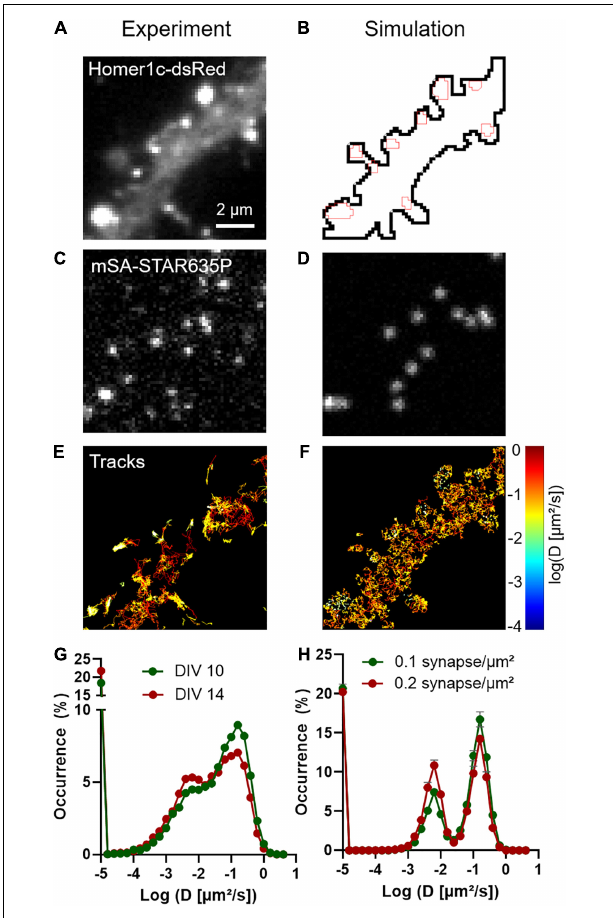
FIGURE 1 | Diffusional trapping of NLGN1 at synapses probed by uPAINT. (A) Raw image of a dendritic segment from a neuron co-expressing BFP + shRNA to NLGN1, AP-NLGN1, BirA ER , and Homer1c-DsRed. (B) The Homer1c-DsRed image was used as a reference to draw the dendrite outline (black) and the PSDs (red areas) entered in the simulator. (C) Biotinylated AP-NLGN1 was sparsely labeled with STAR635P-conjugated mSA, allowing the tracking of individual NLGN1 molecules by uPAINT. (D) Realistic fluorescence rendering of simulated individual NLGN1 molecules in the defined geometry. (E) Image of individual NLGN1 trajectories (2667 tracks), with a color code representing the diffusion coefficient (red = fast diffusion, yellow = slow diffusion). Note the slower NLGN1 diffusion in PSDs. (F) Simulated NLGN1 trajectories based on the diffusion coefficients obtained from uPAINT and binding coefficients deduced from FRAP experiments (621 trajectories). The diffusion color code in logarithmic scale applies to both E and F panels. (G,H) Semi-log distribution of NLGN1 diffusion coefficients obtained by experiment and simulation, respectively. The experimental data is the average distribution of 13 and 9 neurons at DIV 10 and 14, respectively, the number of trajectories analyzed per cell ranging from 949 to 3113. The simulated data is the average ± sem of 5 independent simulations, with trajectory numbers between 625 and 638 per simulation, generated for two different synapse densities (0.1 and 0.2 synapse/ µ m 2 , respectively) from the same dendritic geometry (135 µ m 2 ). The coefficient χ 2 expressing the goodness of fit between simulated and experimental data was 5.6 and 10.5 for DIV 10 and 14 neurons, respectively, as calculated from 28 binned values.